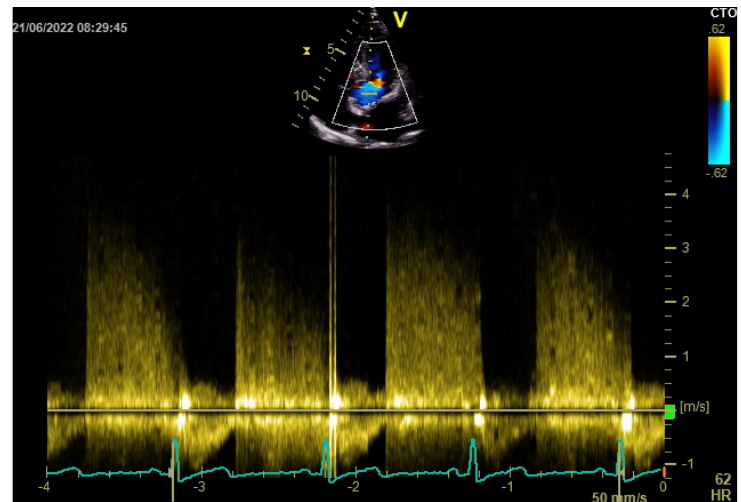
Figure 4. Transthoracic echocardiography: color Doppler echocardiographic images in apical five chamber view and continuous wave Doppler spectrum from the left ventricular outflow tract showed aortic regurgitation flow. The pressure halftime (PHT) was 0.412 seconds.